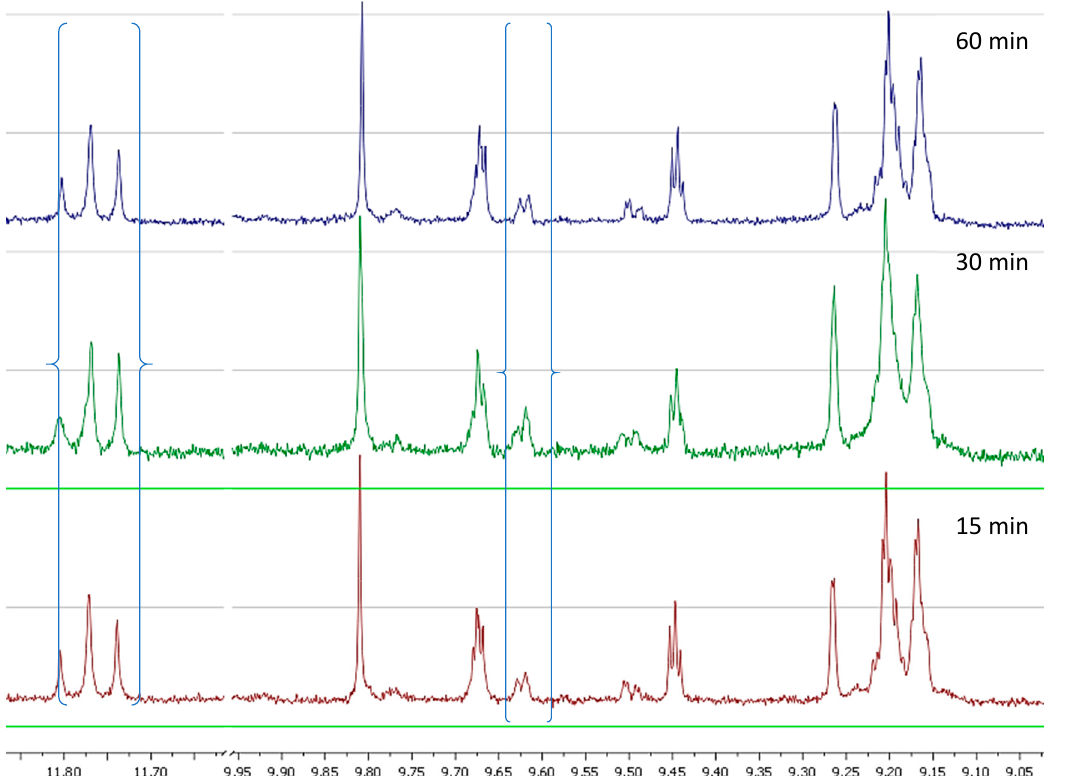
Figure 6. NMR profile of cv Throubolia Aegean at 28 °C, at three malaxation times, showing the characteristic peaks of the analyzed phenolic compounds.